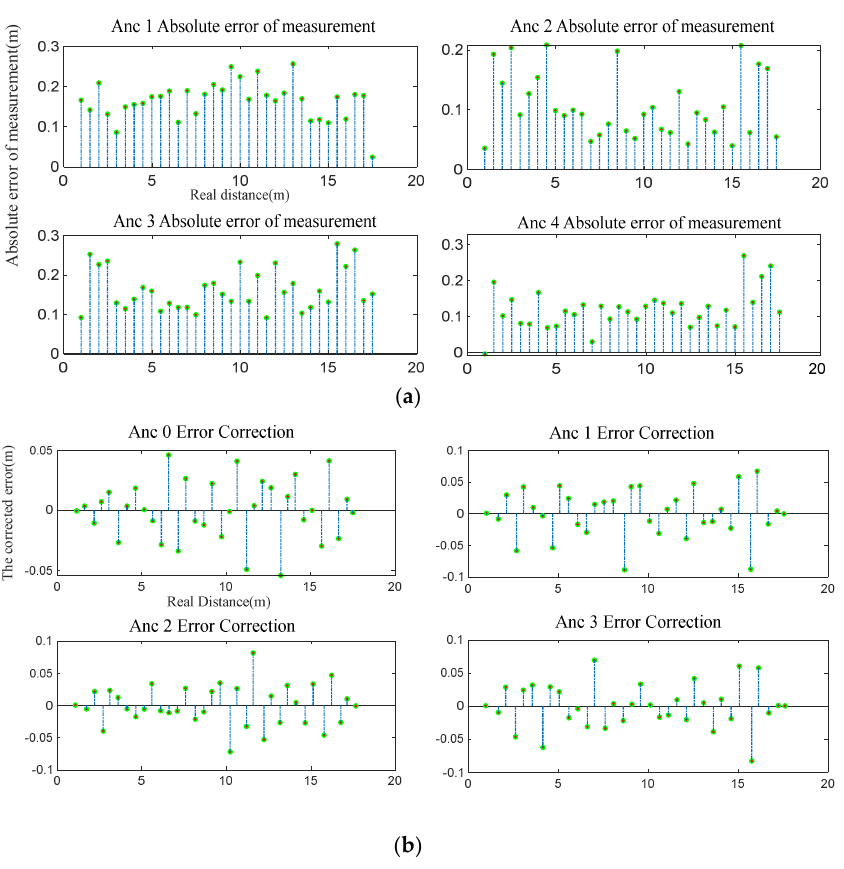
Figure 8. Error plot of polynomial fitting results. ( a ) Distance measurement error and ( b ) error after correction.